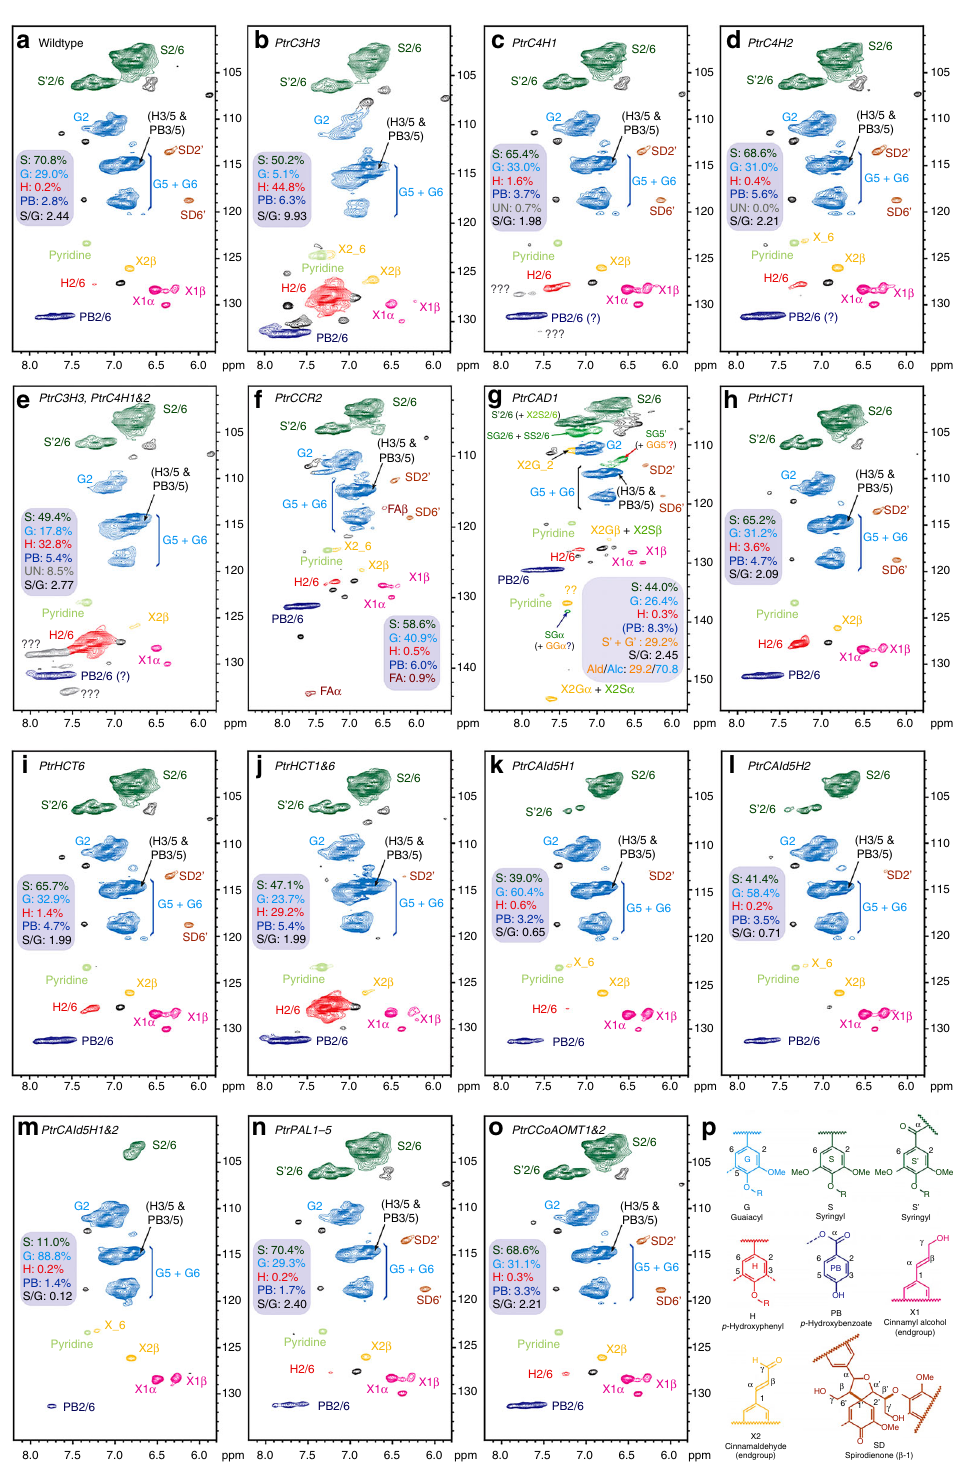
Fig. 6 Composition of lignin quanti fi ed by 2D NMR. Partial (aromatic and double-bond regions) short-range 2D 1 H – 13 C correlation (HSQC) spectra of enzyme lignin from wildtype ( a ), and an example of a transgenic P. trichocarpa line for each construct downregulated in the gene expression of b PtrC3H3 , c PtrC4H1 , d PtrC4H2 , e PtrC3H3 and PtrC4H1 & 2 , f PtrCCR2 , g PtrCAD1 , h PtrHCT1 , i PtrHCT6 , j PtrHCT1 & 6 , k PtrCAld5H1 , l PtrCAld5H2 , m PtrCAld5H1 & 2 , n PtrPAL1 – 5 , o PtrCCoAOMT1 & 2 . S/G ratio and the percentage volume integrals of major lignin components are from contour volume integrals. p The chemical structures of the lignin monomeric subunits, color-coded to match their signal assignments in the spectra. See Supplementary Data 4 for all 2D NMR